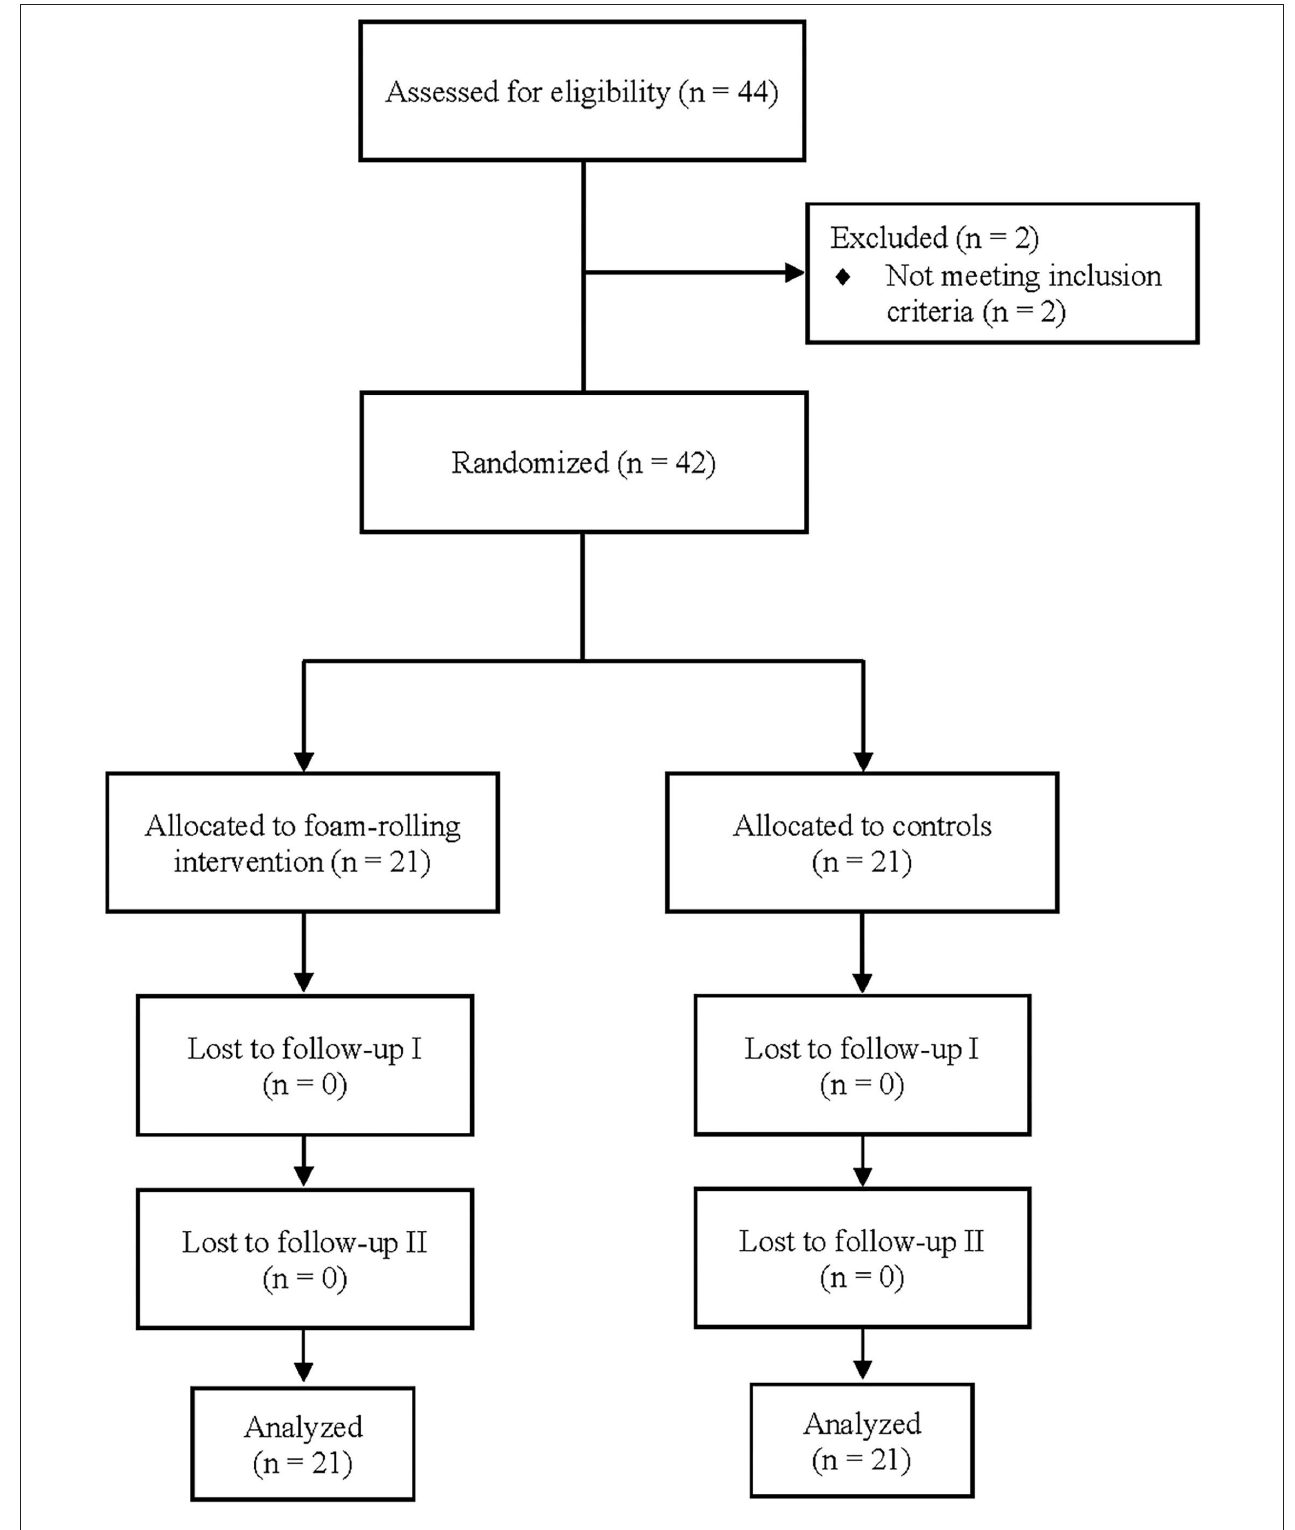
FIGURE 3 | Study flow